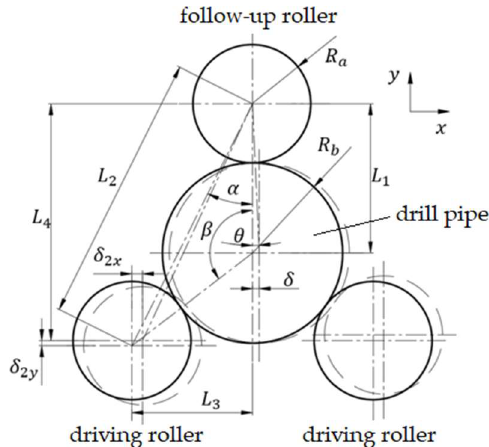
Figure 2. Diagram of deviation analysis.